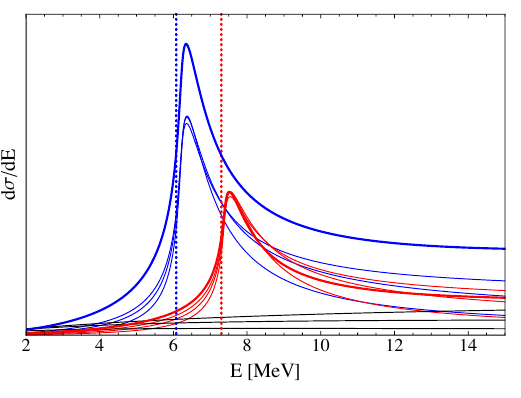
Figure 4. d σ/ dE for T + π + (left blue cc π 0 (right red curves), and T + π − curves), T + cc cc (lower black curves). The binding energy of T + is | ε T | = 360 keV. The thicker curves cc π + and T + π 0 were calculated using for T + cc cc Eqs. (13). The thinner curves are for the coupled-channel model with Λ / m π = 1 / 2, 1, and 2 in order of increasing cross sections at small E and at large E .